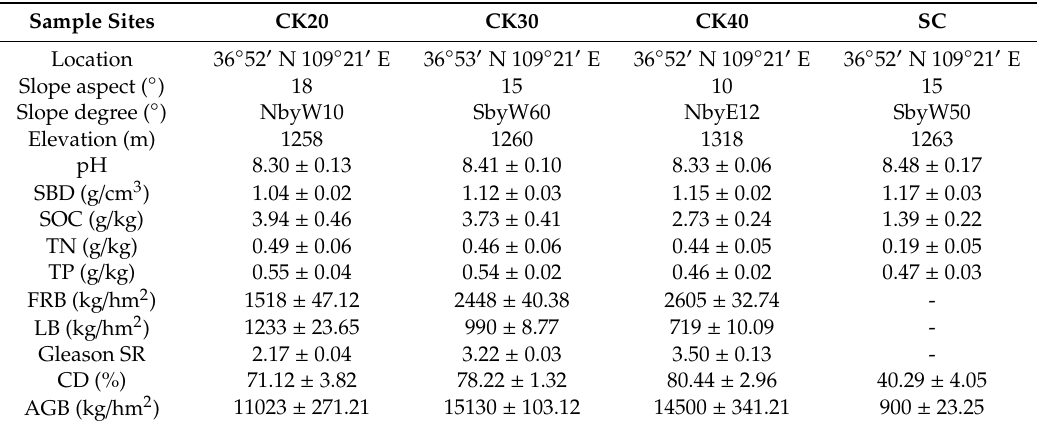
Table 1. Characteristics of the sampling